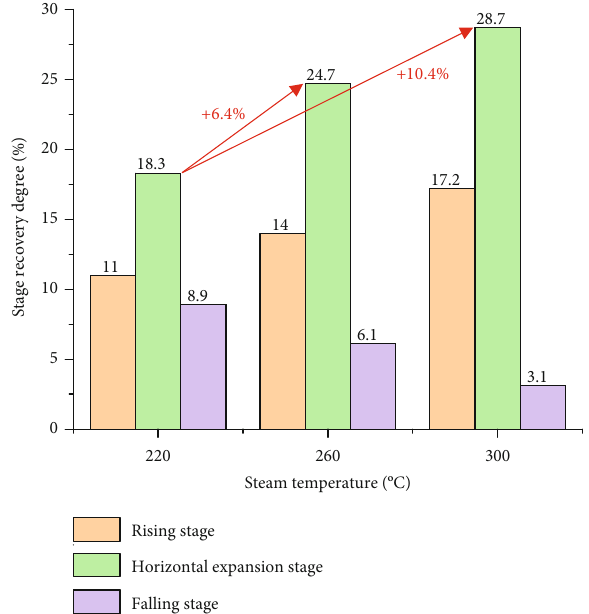
Figure 18: Stage recovery degrees at di ff erent steam